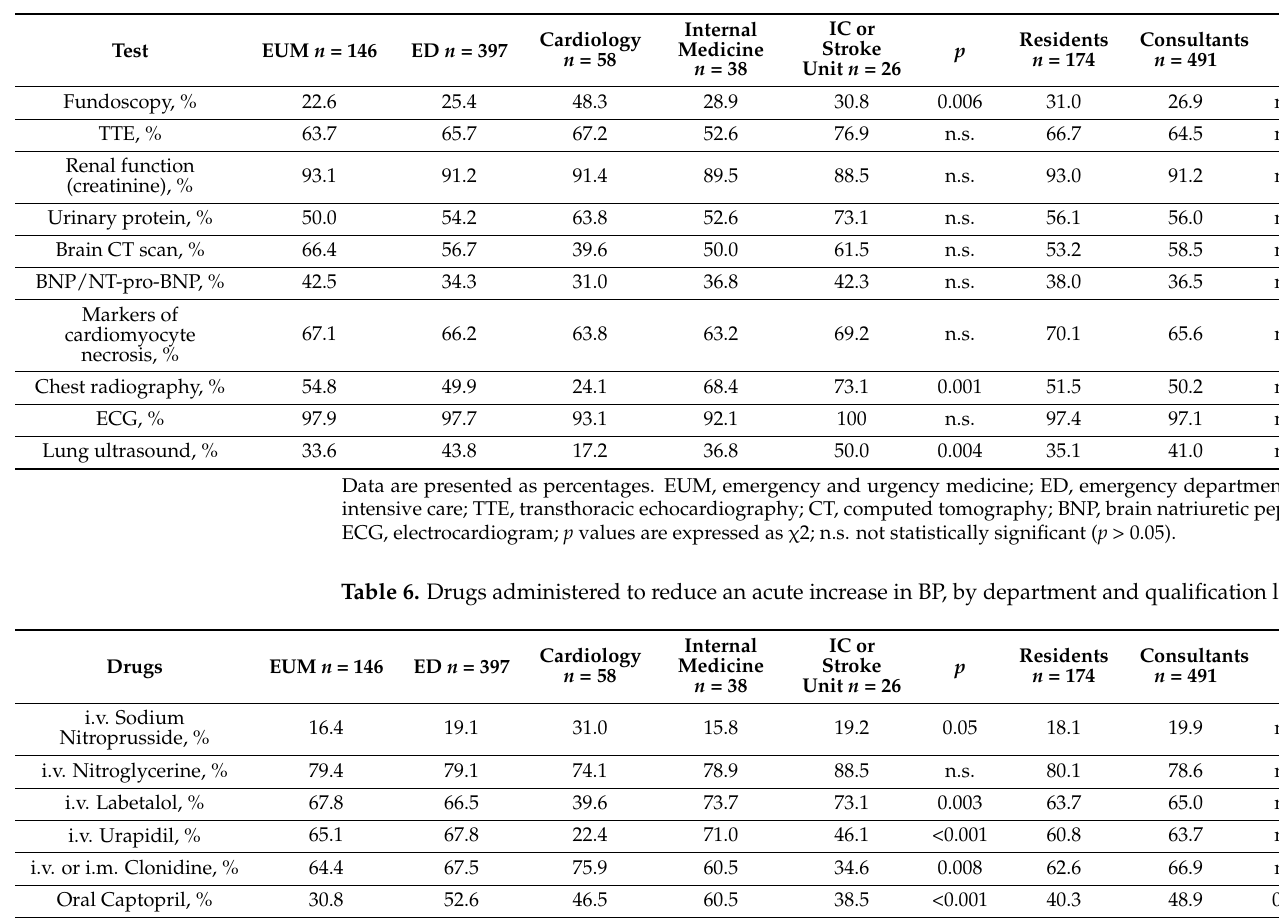
Table 5. Tests available and prescribed to identify acute target organ damage due to an acute rise in BP, by department and qualification level.